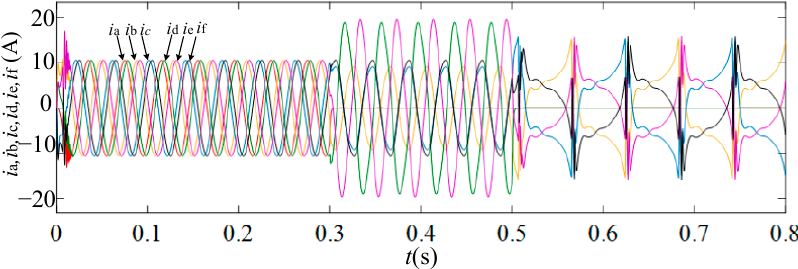
Figure 13. Current waveforms of phase a and phase d at 0.3 s and 0.5 s open-circuit fault, respectively.